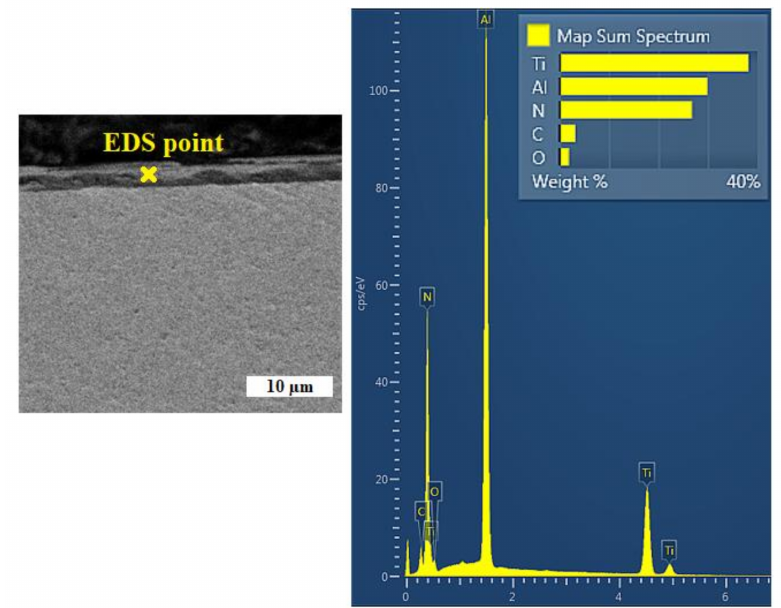
Figure 6. Selected site for spot analysis of the coating with the EDS recording of individual